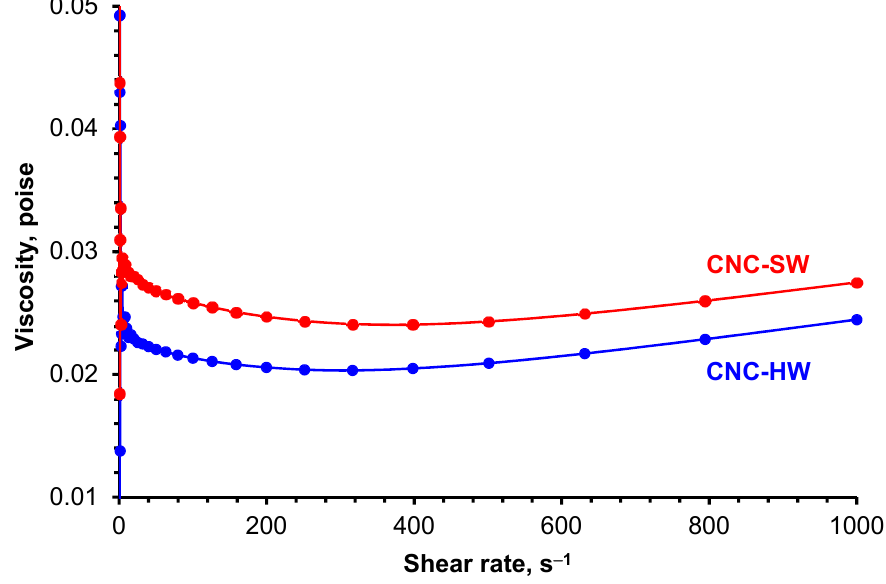
Figure 9. Viscosity compression of CNC from HW and SW.